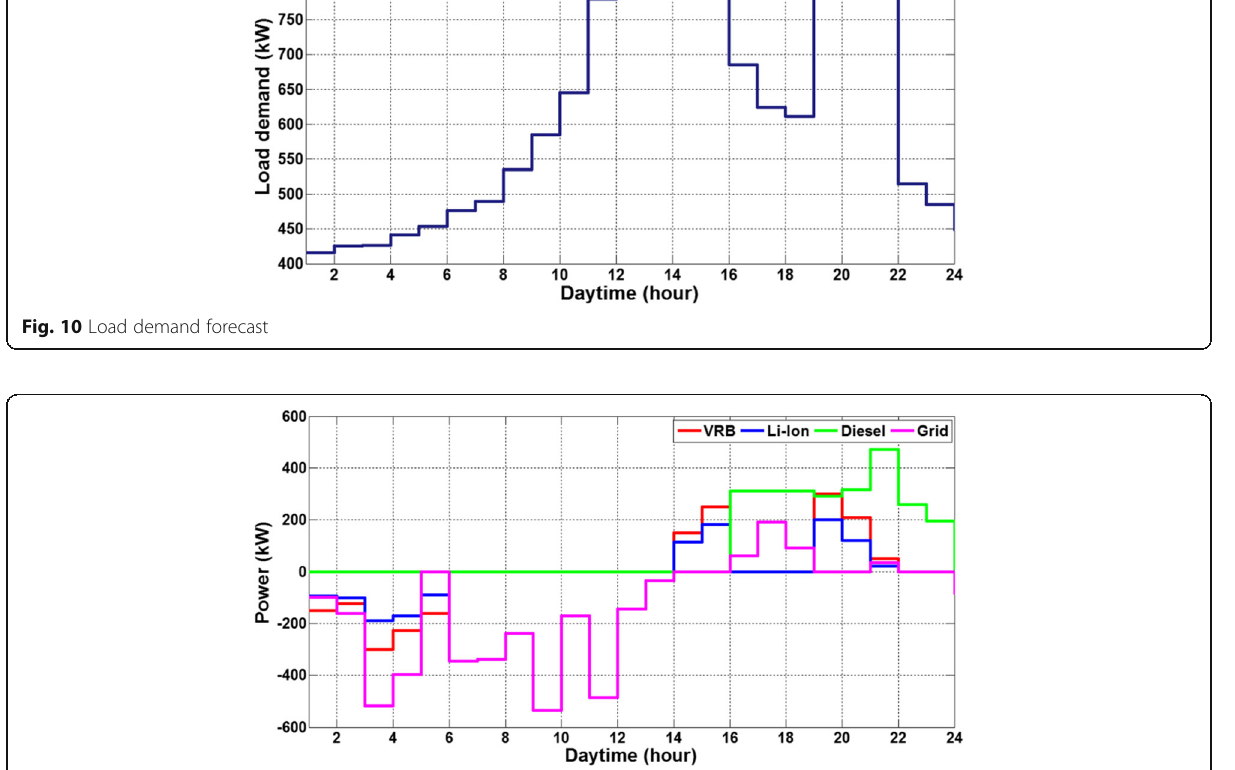
Fig. 11 Optimal dynamic scheduling using RegPSO in non-isolated operation mode